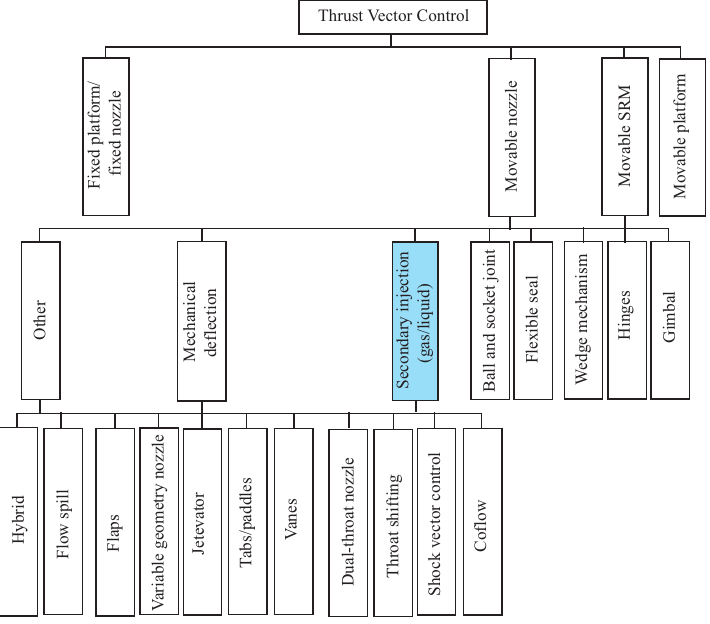
Figure 1. Thrust vector control systems for solid propellant rocket